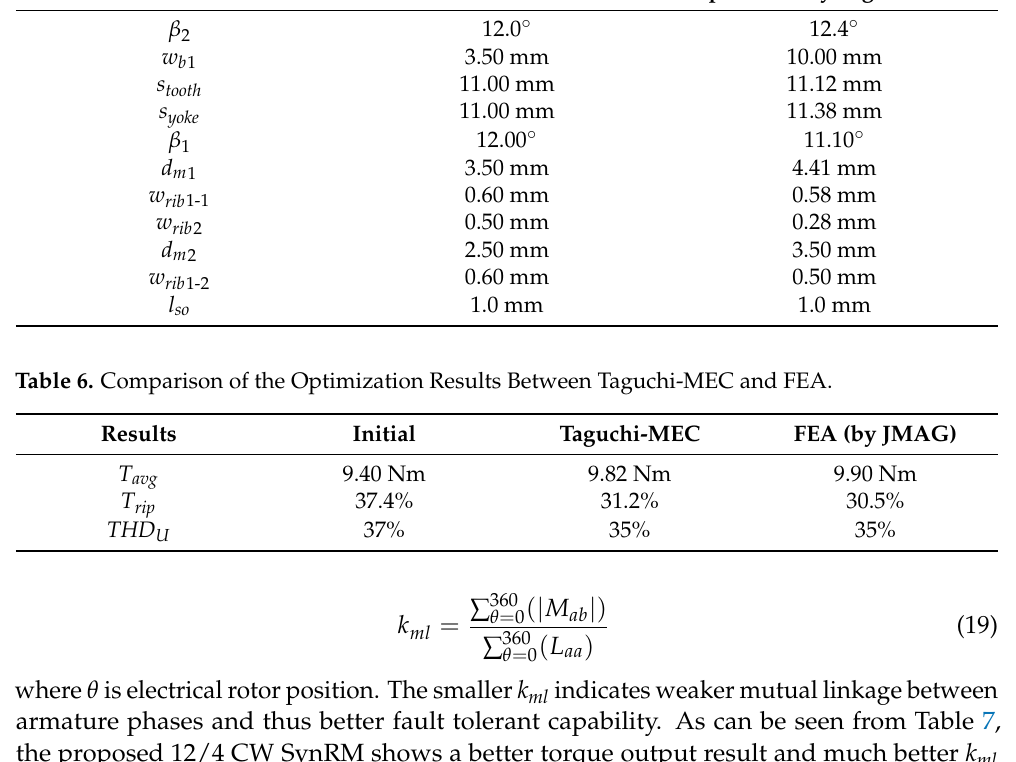
13 of 17 Table 5. Comparison of the Parameters and Performances. Parameters